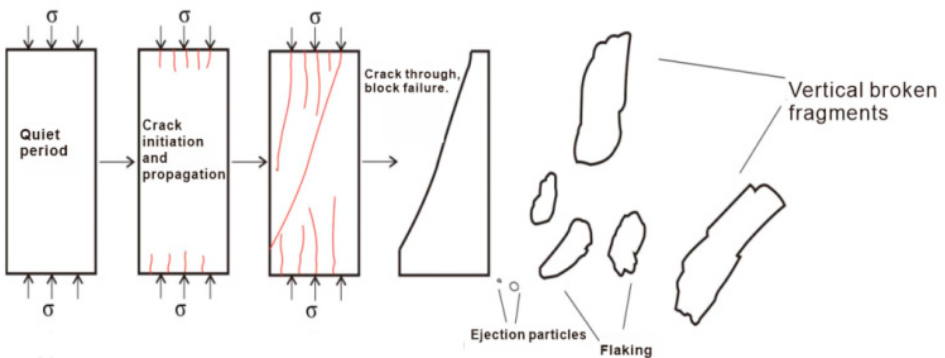
Figure 9. Test results and failure modes of granite with confining pressure at 0 MPa.